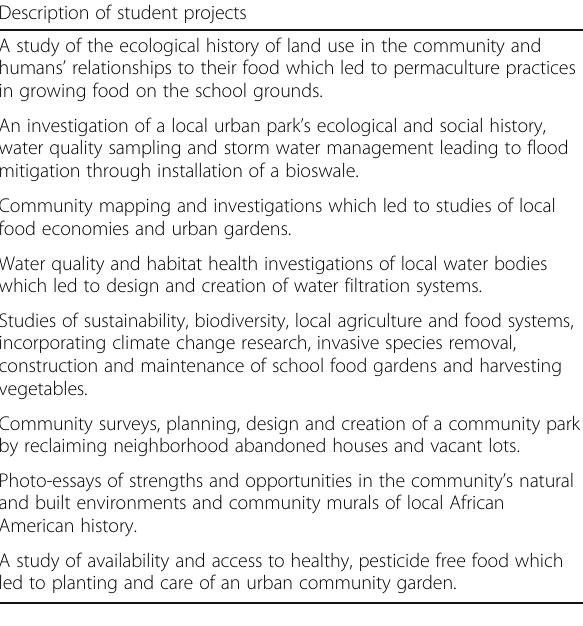
Table 1 Student Project Content Description of student